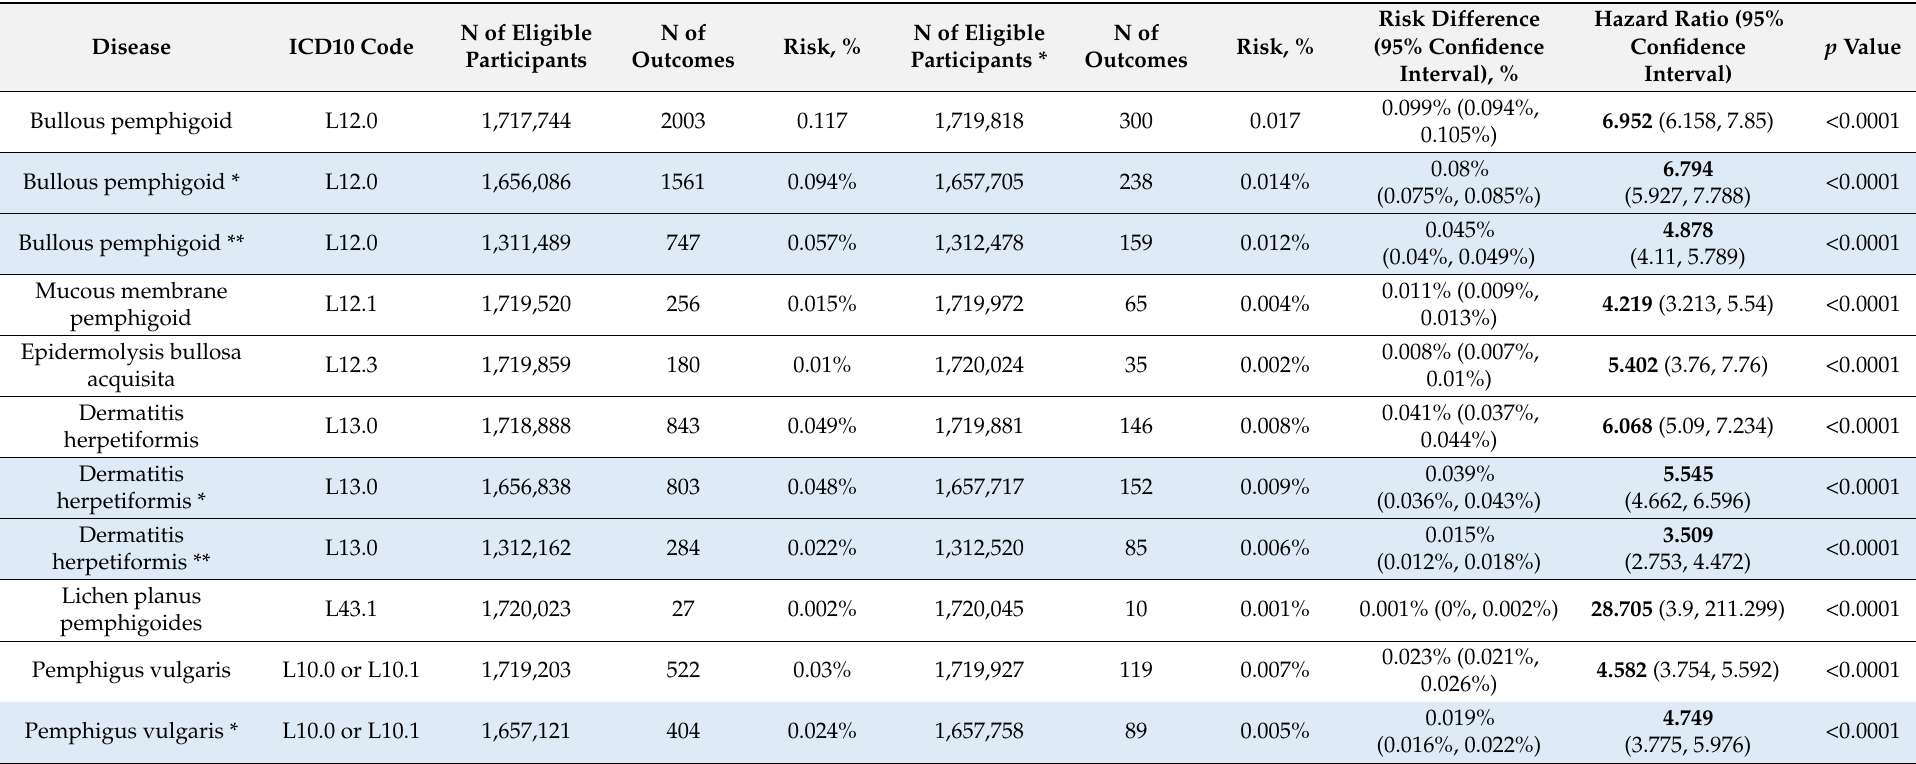
Table 3. Pruritus is associated with a higher risk for the subsequent development of pemphigus and pemphigoid diseases. The risk of developing any of the listed pemphigus or pemphigoid diseases for individuals diagnosed with pruritus (cases, ICD10:L29) compared to those without (controls, ICD10:Z00, not ICD10:L29). Data shown display results from measures of association, excluding patients with the corresponding pemphigus or pemphigoid disease prior to the time window for the hazard ratio. Kaplan-Meier analysis (again excluding patients with outcome prior to the time window) with log-rank test was performed.